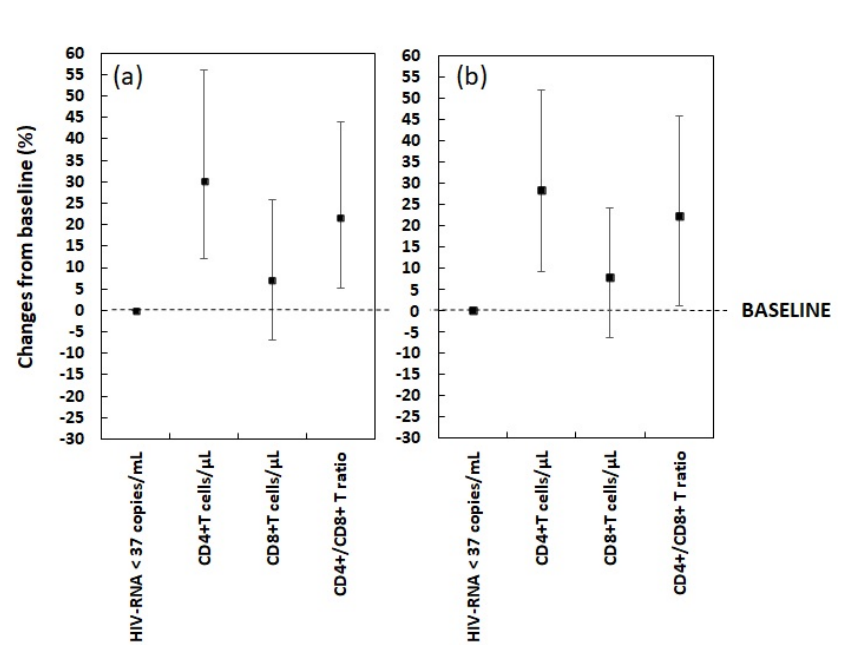
Figure 1. Immunovirological changes (%) from baseline: Plot report differences in immunovirological profile comparing baseline with week 48 in ( a ) overall patients and ( b ) >55 years old population. Ranked mean relative difference for each marker. Vertical bars indicate the IQR. The same axis value ranges were used in each case for ease of comparison.